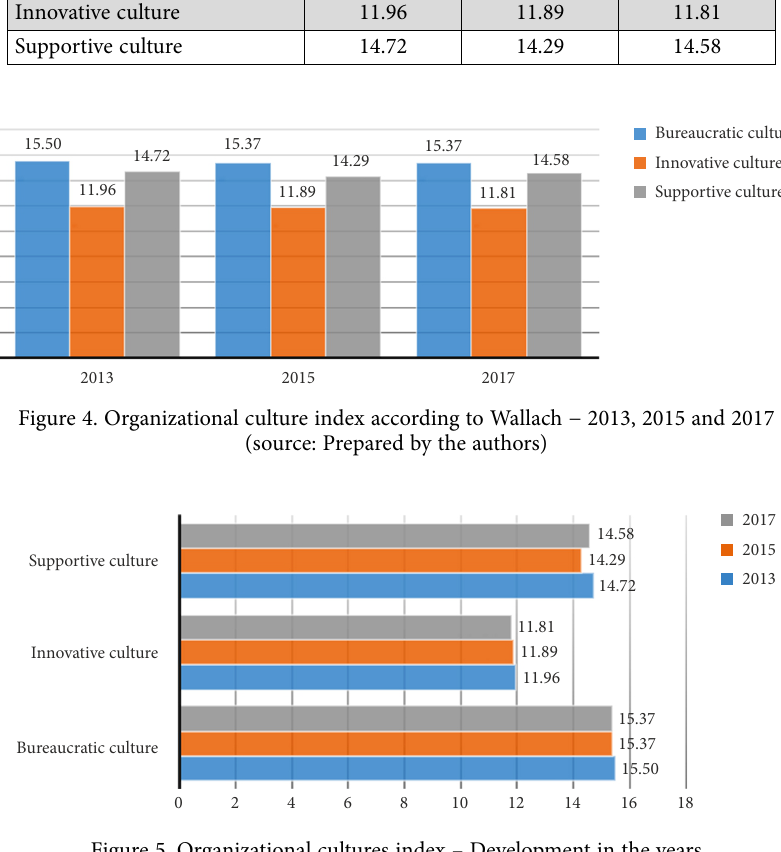
Figure 5. Organizational cultures index – Development in the years (source: Prepared by the